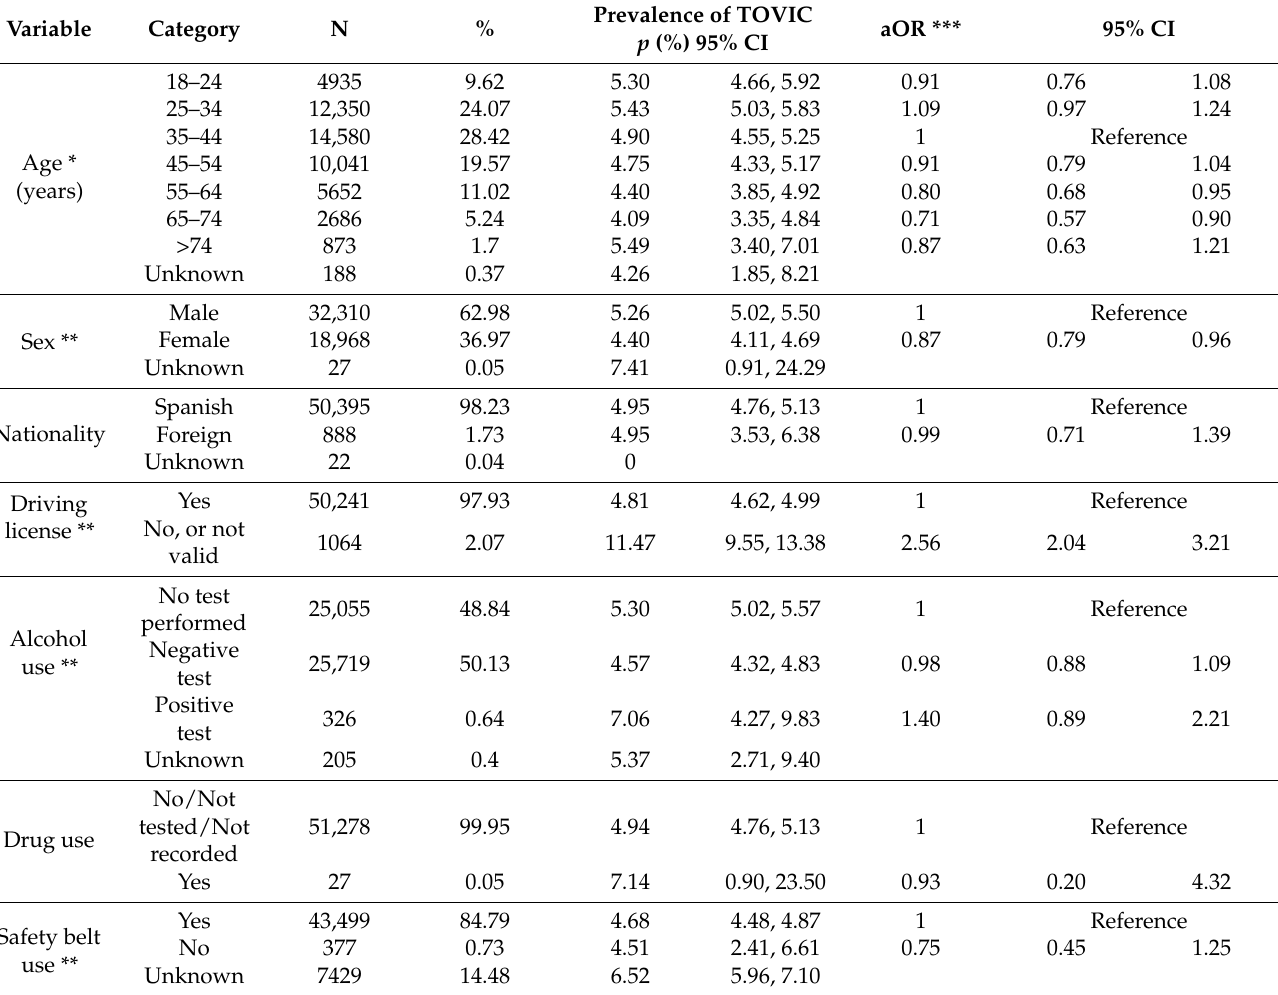
Table 1. Distribution of variables in the sample, prevalence of TOVIC in each category, and adjusted odds ratios for the association between TOVIC and each category of driver-related